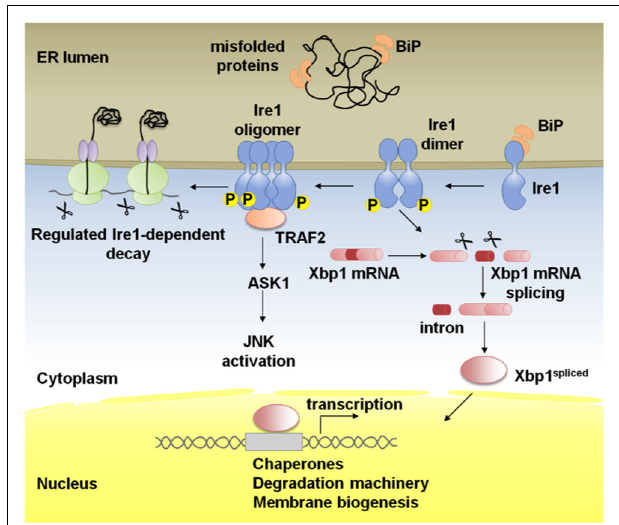
FIGURE 1 | Schematic representation of Ire1 signaling. Binding immunoglobulin protein (BiP) binds Ire1 luminal domain and maintains it in a monomeric inactive form. In stressed cells, BiP is recruited to misfolded proteins and Ire1 is activated following conformational changes induced by dimerization of monomers in the plane of the membrane and trans-autophosphorylation. Higher order oligomers, which might form upon additional stress stimuli, reinforce Ire1 RNase activity. Activated Ire1 mediates the splicing of Xbp1 mRNA in higher eukaryotes (or Hac1 in yeast). Splicing of the intron from the Xbp1 transcript results in a frame-shift and the production of a potent transcription factor, Xbp1-spliced, that regulates many UPR target genes to promote protein folding in the ER lumen, ER-associated degradation (ERAD) of misfolded proteins and ER biogenesis. Ire1 can also act by alternative pathways; phosphorylated Ire1 associates withTRAF2 and activates the JNK pathway via ASK1. In the regulated Ire1 dependent decay (RIDD) pathway, Ire1 degrades mRNAs localized to the ER membrane through its RNase activity leading to a reduction in the amount of proteins imported into the ER